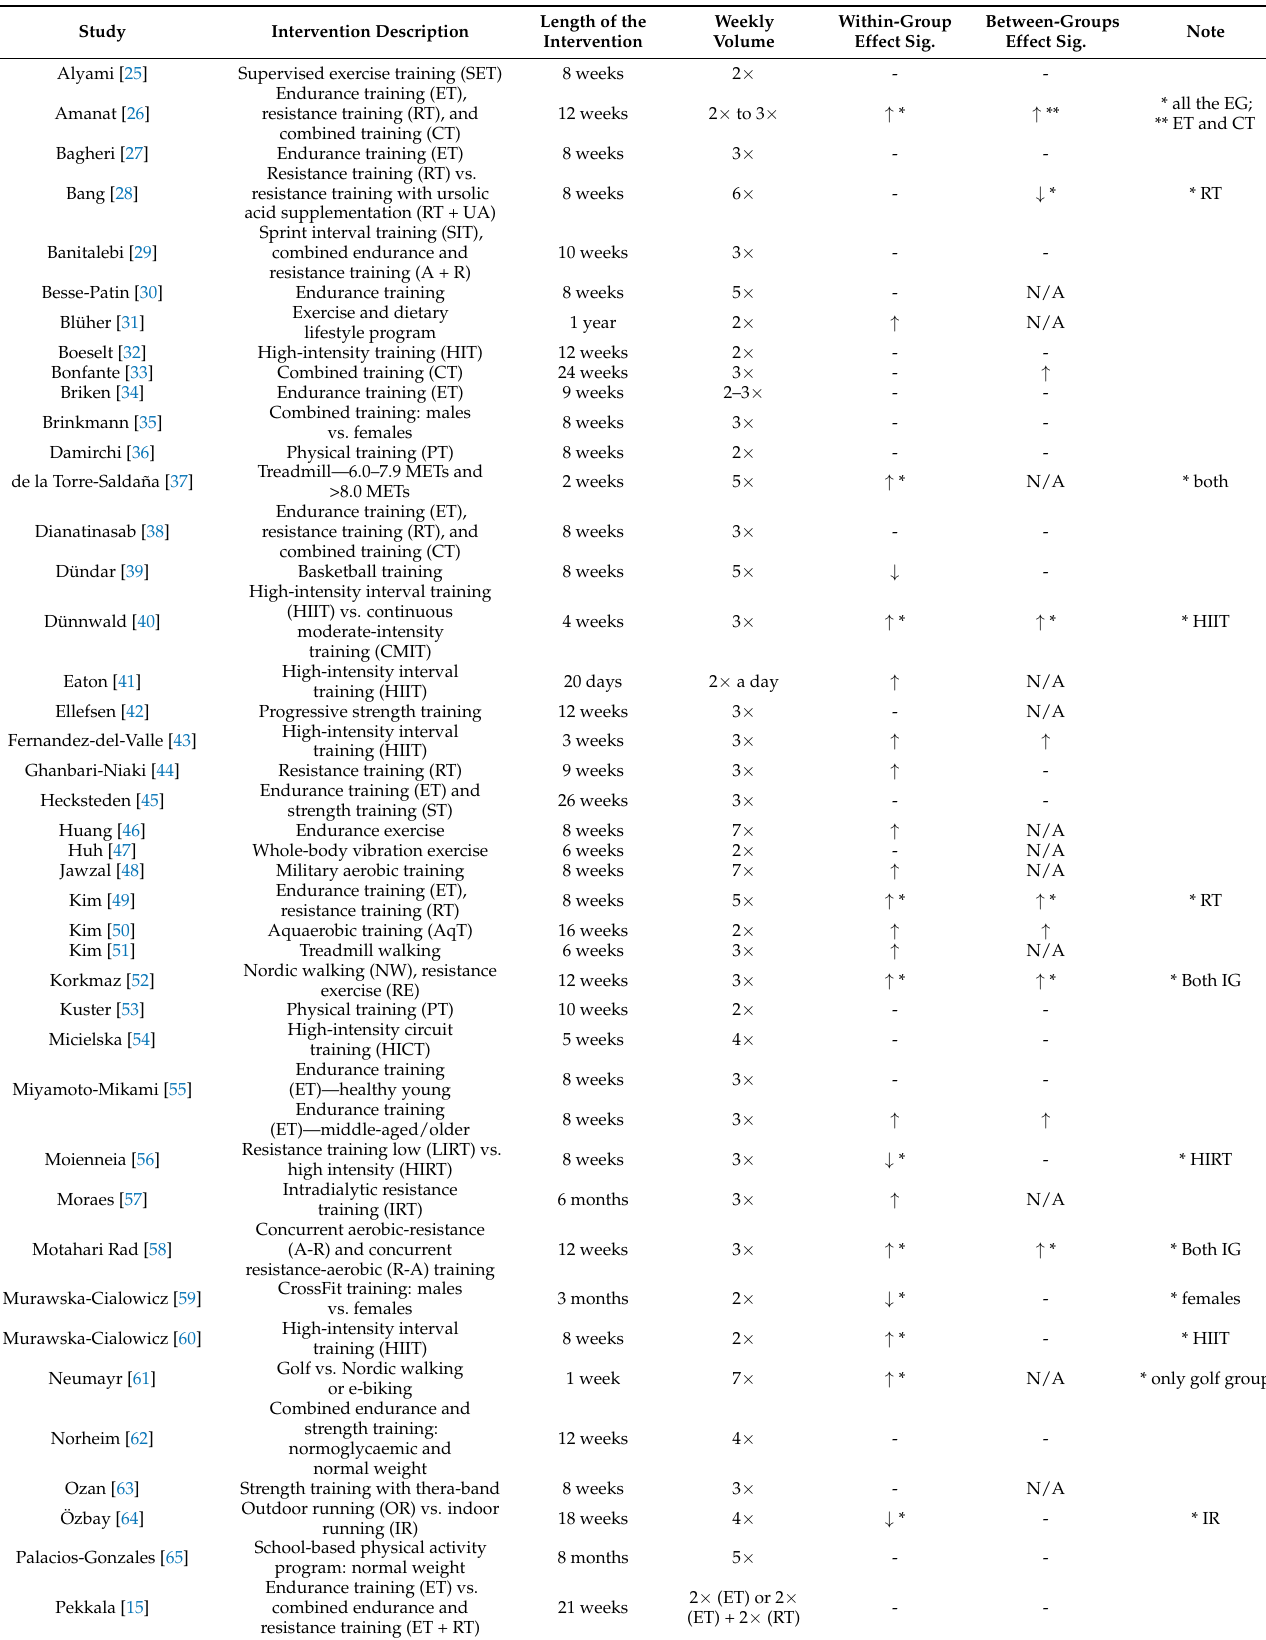
Table 3. Studies focused on the long-term effect of physical exercise on blood irisin